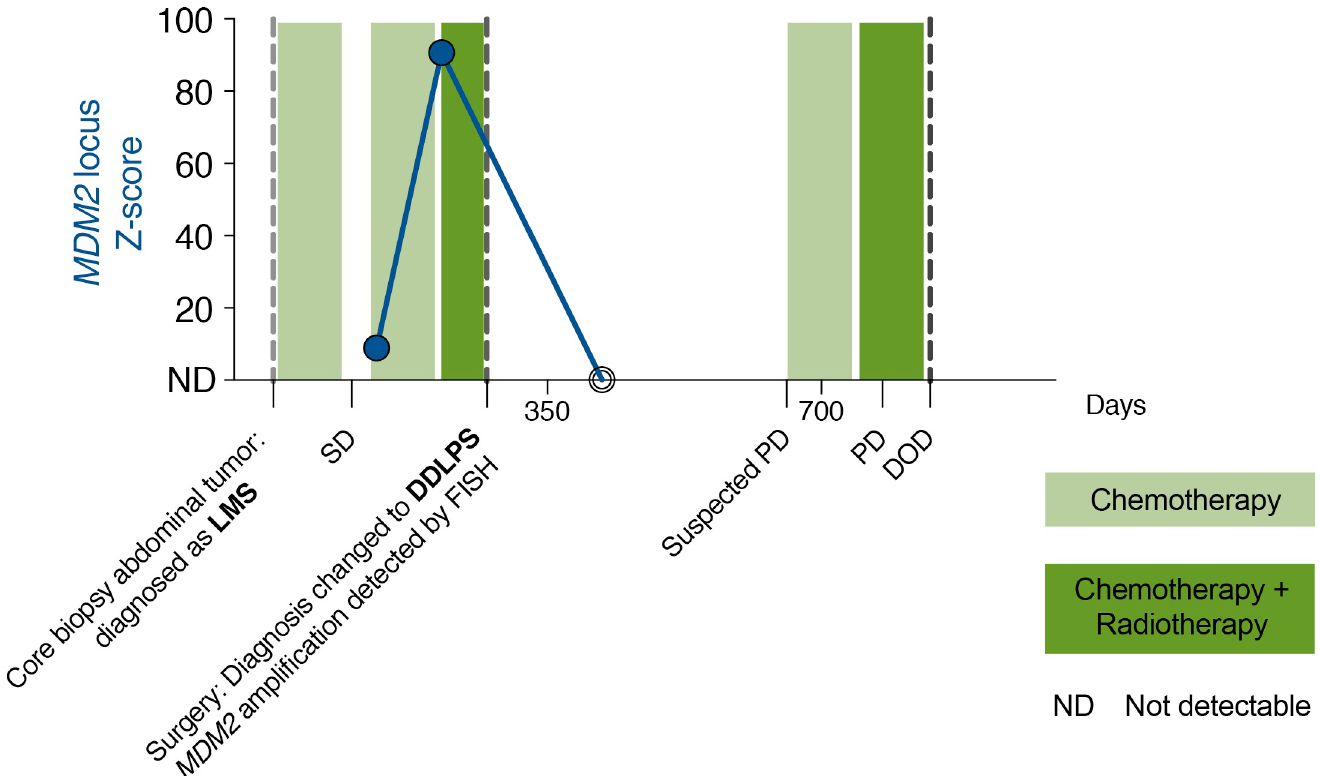
Fig 3. Longitudinal monitoring of MDM2 amplification in cell-free DNA of patient DDLPS1. [SD–stable disease; PD–progressive disease, DOD–died of disease, ND–not detectable].